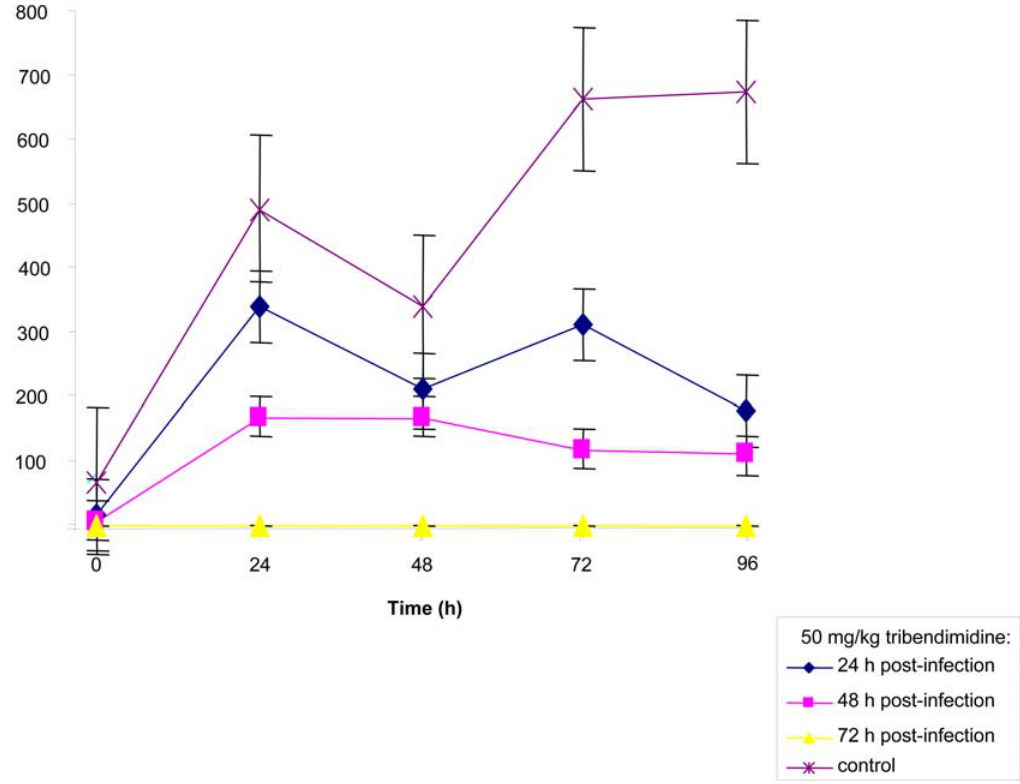
Figure 3. Mean (SE) fecal larvae output of 4 S.ratti -infected rats that remained untreated and S.ratti- infected rats treated with 50 mg/kg tribendimidine either on day 1, 2 or 3 post-exposure.